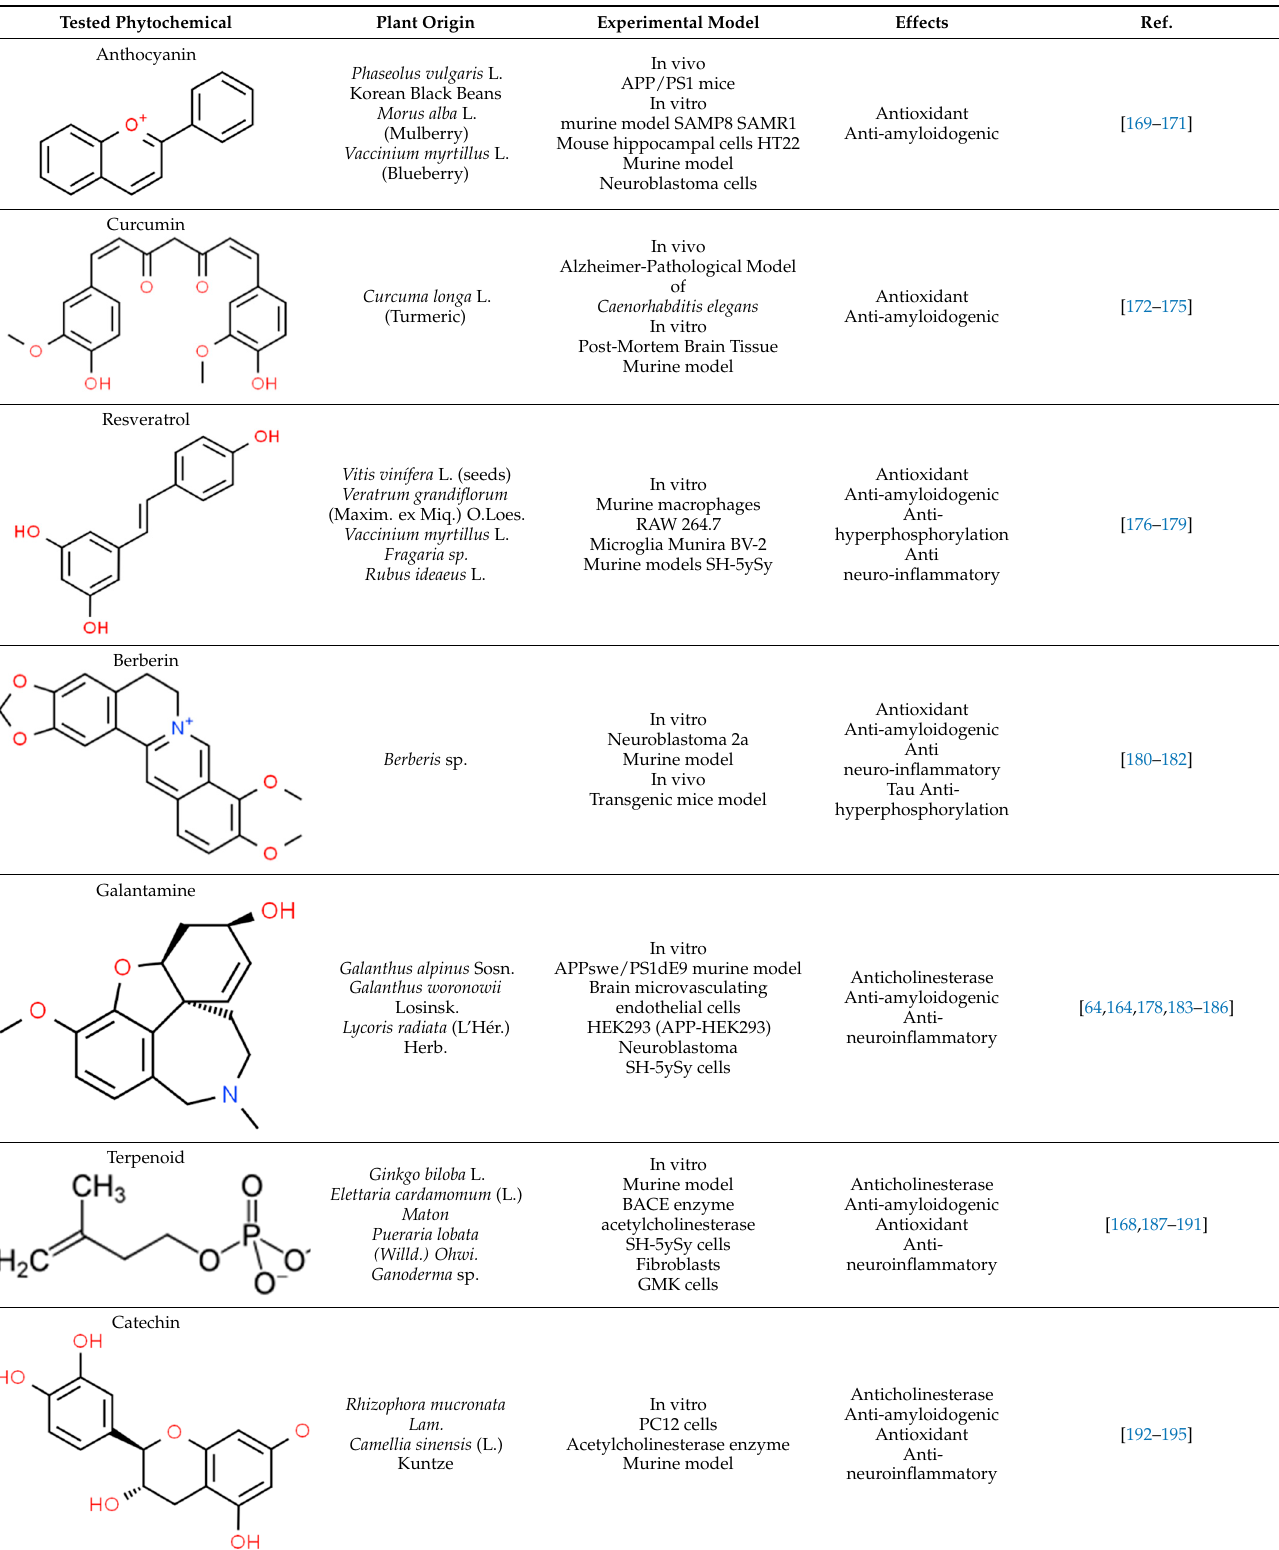
Table 2. Summarized data regarding pharmacological effects of phytochemicals as potential agents in AD management.